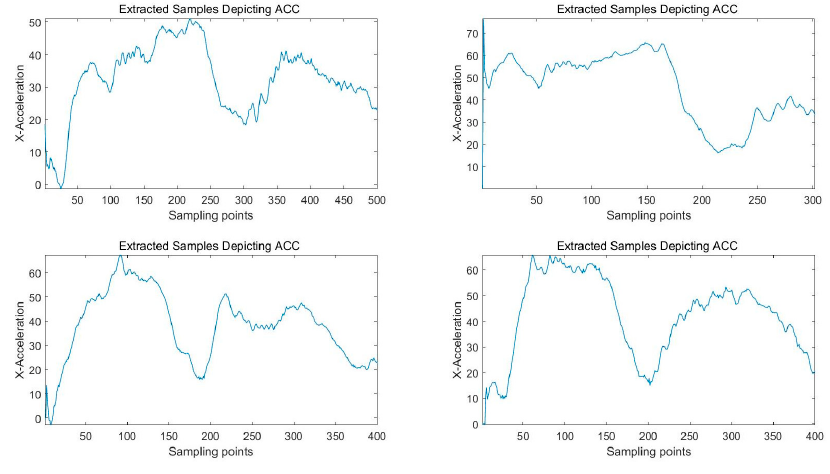
Figure 11. Four samples extracted depicting ACC.